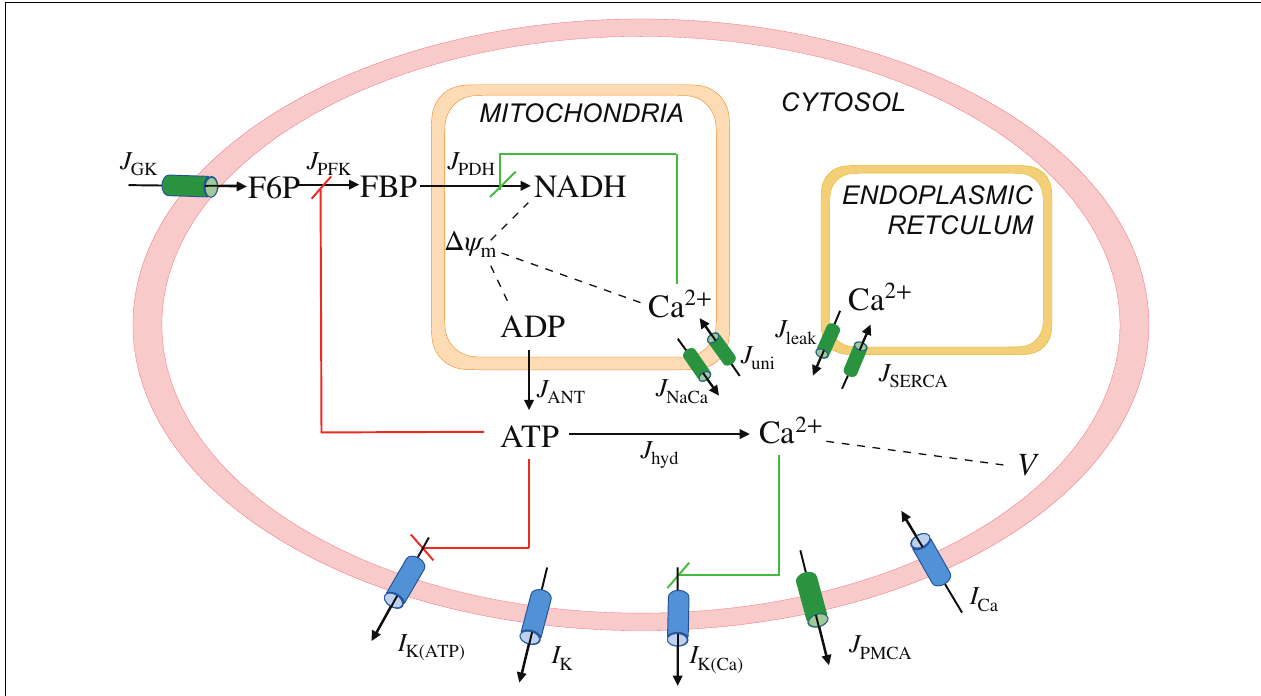
FIGURE 1 | Illustration of the Integrated Oscillator Model ( IOM). The model consists of three modules. A first module describes the β -cell electrical activity and Ca 2 + dynamics, the second describes key elements of glycolysis, and the third accounts for the mitochondrial metabolism. The second and third modules together make up the metabolic subsystem. I , ionic currents; J , fluxes; K(ATP), ATP-sensitive K + channels; K, delayed rectifier K + channels; K(Ca), Ca 2 + -activated K + channels; PMCA, plasma membrane Ca 2 + ATPase; Ca, V -dependent Ca 2 + current; GK, glucokinase; PFK, phosphofructokinase; PDH, phosphate dehydrogenase; ANT, adenine nucleotide translocator; hyd, hydrolysis; NaCa, Na + -Ca 2 + exchanger; uni, uniporter; leak, Ca 2 + leak across the ER membrane; SERCA, sarcoplasmic endoplasmic reticulum Ca 2 + pumps; V and (cid:52) ψ m , cellular and mitochondrial membrane potential, respectively. The red and green lines represent negative and positive feedback,